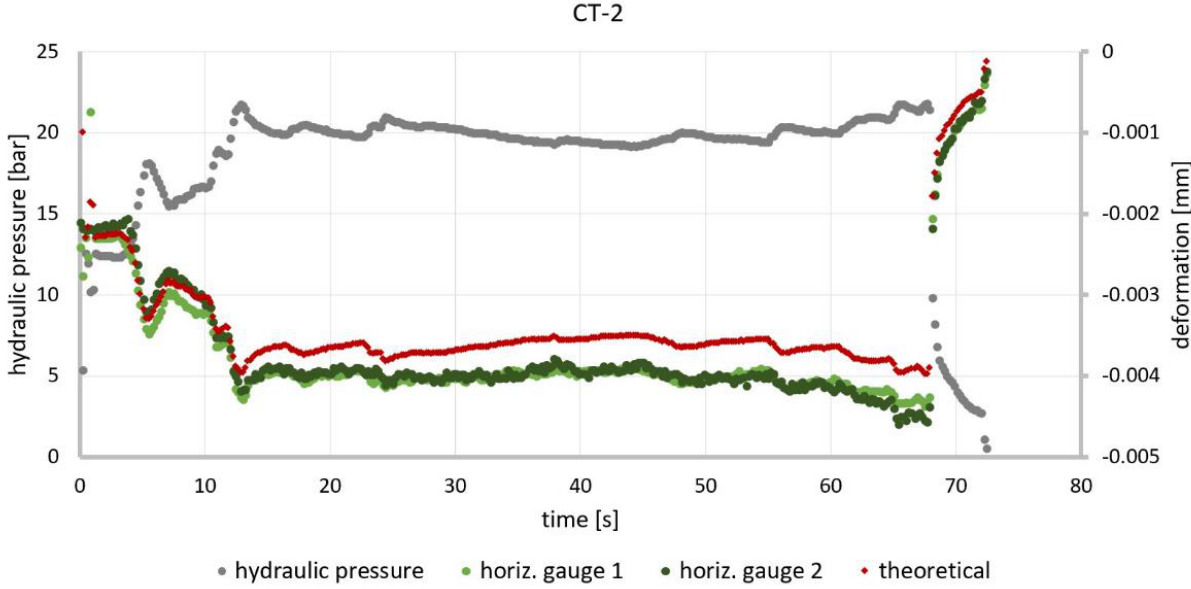
Figure 9. Comparison of the measured (test CT−2) and theoretical ( 𝐸 𝑐 = 22,000 MPa, 𝜈 = 0.2 ) horizontal deformations (strain) with respect to the applied hydraulic pressure.